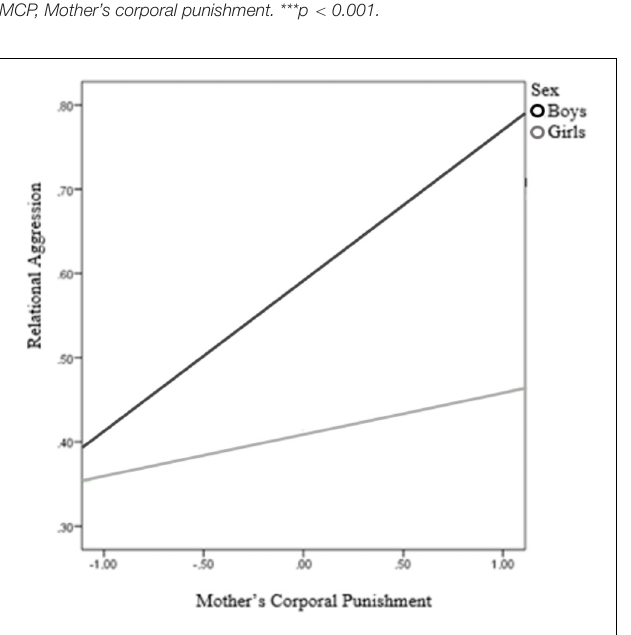
FIGURE 7 | Child’s sex as a moderator between mother’s corporal punishment and relational